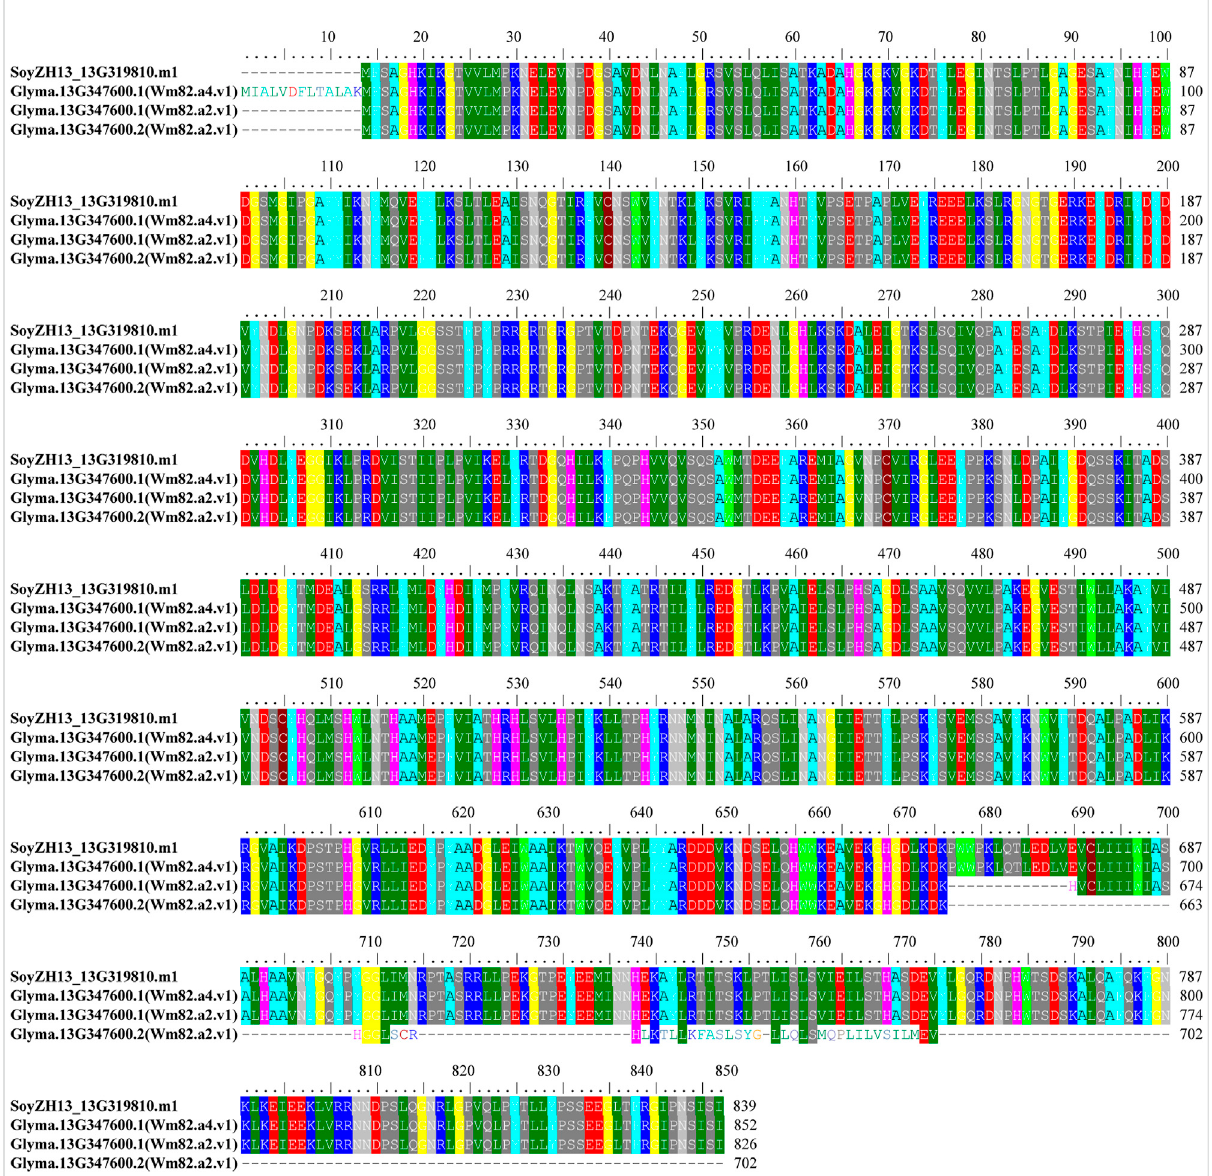
FIGURE 2 Alignment result of the modi fi ed GmLOX1 protein sequence in Zhonghuang 13 with different versions of GmLOX1 of Williams 82 Note: SoyZH13_13G319810 isthesequenceIDof GmLOX1 inZhonghuang13. Glyma.13G347600 isthesequenceIDof GmLOX1 inWilliams82,andthereis one transcript in Wm82.a4.v1 and two transcripts in